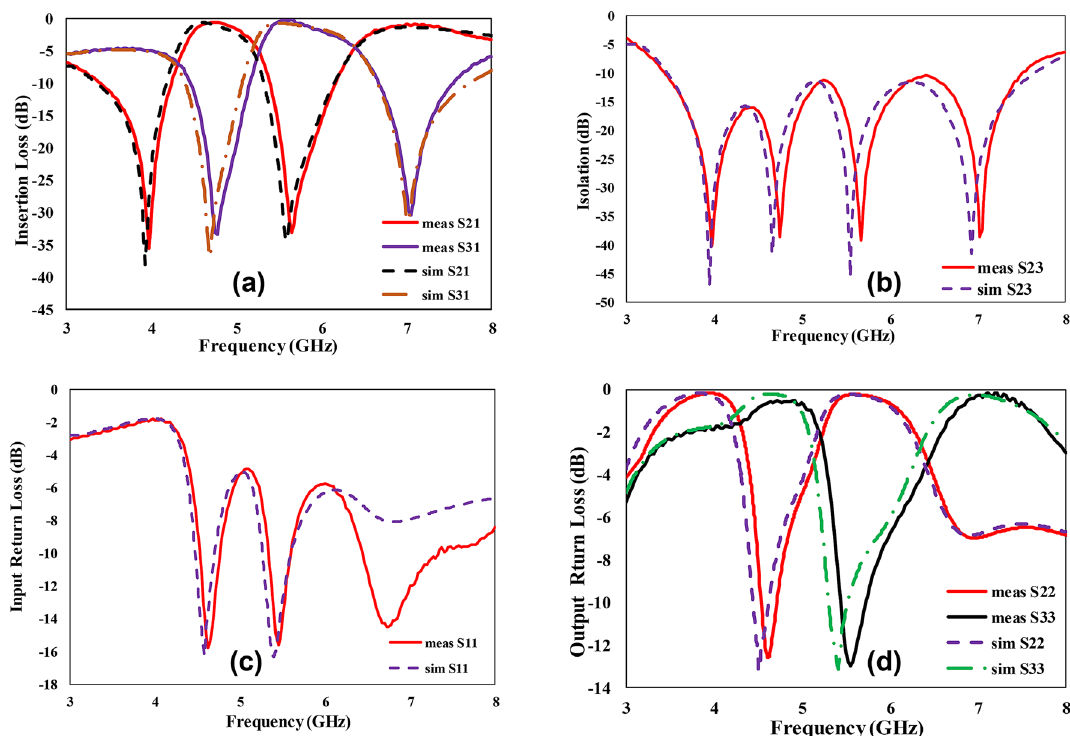
Figure 5. Scattering parameters of the proposed EIT-based microstrip diplexer ( a ) measured and simulated insertion loss, ( b ) measured and simulated isolation between the two channels, ( c ) measured and simulated input return loss ( d ) measured and simulated output return